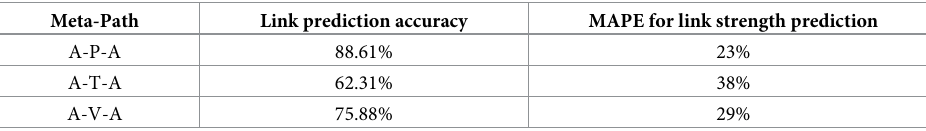
Table 1. Performance of different meta path